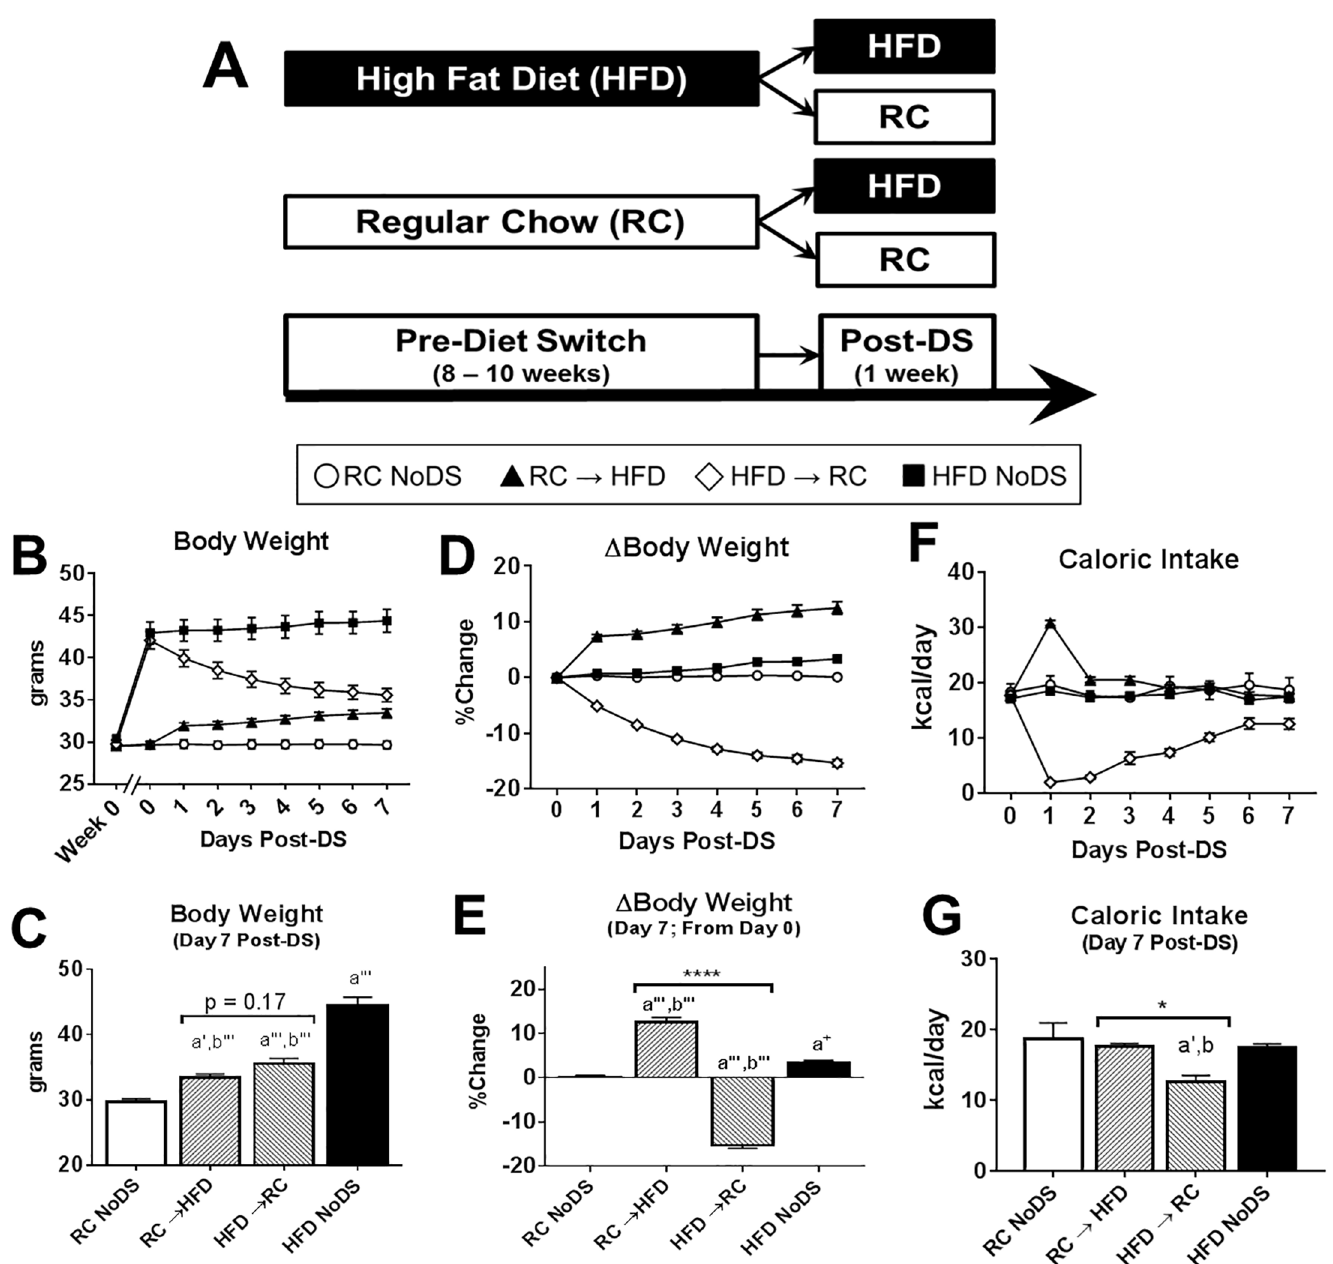
Fig 1. Diet Switch (DS) feeding paradigm isolates ‘body weight’ from ‘diet and/or energy balance’ factors. (A) Experimental design schematic. Mice consume either RC or HFD for 8–10 weeks (Pre-DS), then are randomized to either continue consuming their respective diet (RC NoDS and HFD NoDS) or switched to the alternate diet (RC ! HFD and HFD ! RC). All mice were sacrificed Day 7 Post-DS. (B) Absolute body weight across the study. (C) Absolute body weight at Day 7 Post-DS. (D) Percent change in body mass ( Δ BodyWeight) normalized to Pre-DS weights (Day 0 Post-DS). (E) Δ Body weight on Day 7 Post-DS (normalized to Pre- DS weight). (F) Caloric intake from Pre-DS (Day 0) to Day 7 Post-DS. (G) Average caloric intake on Day 7 Post-DS. (cid:3) p < 0.05, (cid:3)(cid:3)(cid:3)(cid:3) p < 0.0001 comparing RC ! HFD vs HFD ! RC; a + : p < 0.1, a: p < 0.05, a’: p < 0.01, a”: p < 0.001, a”‘: p < 0.0001 compared to RC NoDS; b + : p < 0.1, b: p < 0.05, b’: p < 0.01, b”: p < 0.001, b”‘: p < 0.0001 compared to HFD NoDS. Sample sizes for B-E: [RC NoDS, n = 16; RC ! HFD, n = 21; HFD ! RC, n = 19; HFD NoDS, n = 14]. Sample sizes for F-G: [RC NoDS, n = 15; RC ! HFD, n = 21; HFD ! RC, n = 18; HFD NoDS, n = 14].